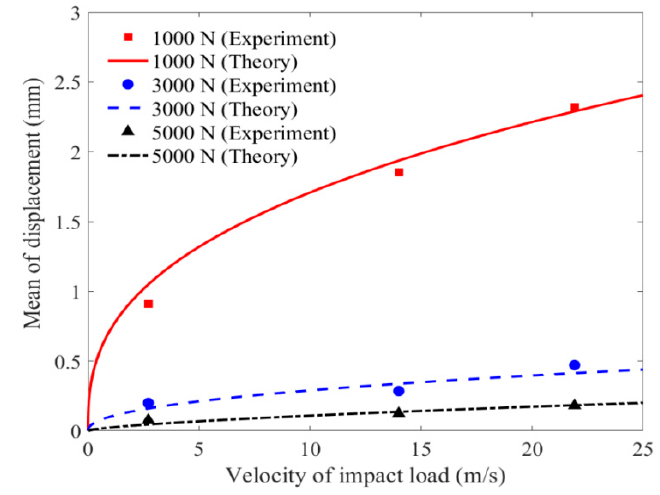
Figure 18. Mean value of displacement versus velocity of impact wind.